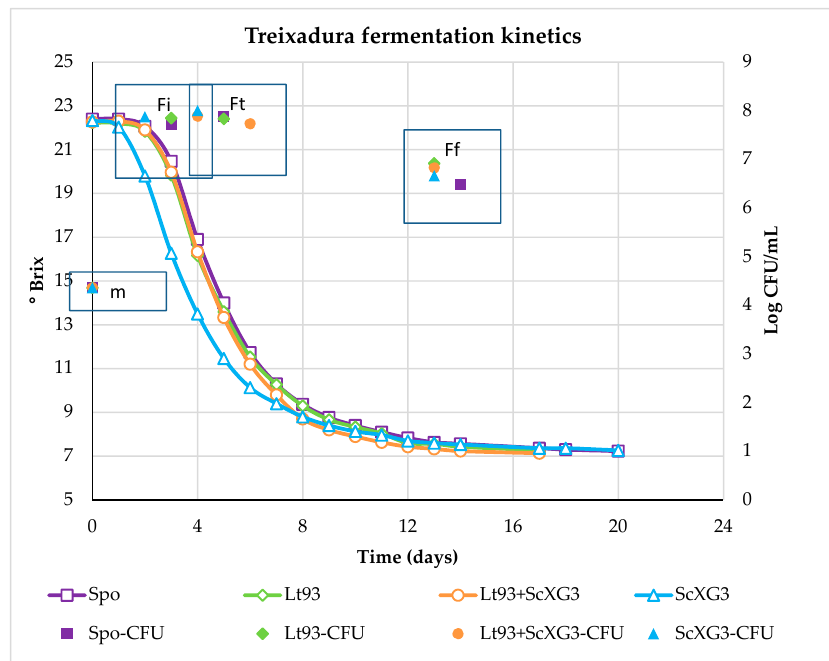
Figure 1. Evolution of ° Brix and yeast population (CFU/mL) during fermentation of Treixadura with S. cerevisiae ScXG3 and L. thermotolerans Lt93 in monoculture, sequential fermentation (Lt93+ScXG3) and spontaneous process (Spo). M—must; Fi—initial fermentation; Ft—tumultuous fermentation; Ff—final